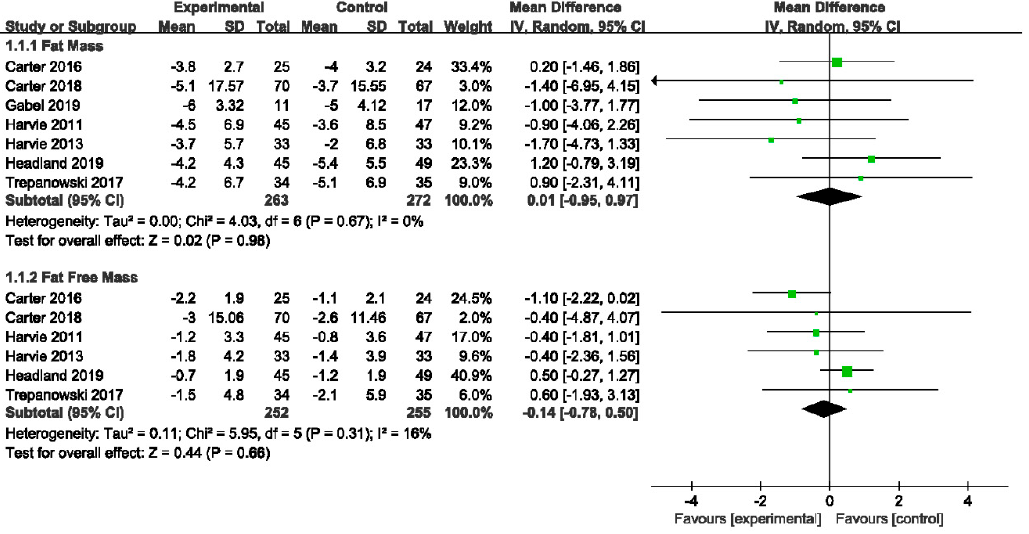
Figure 6. Forest plot for body composition in trials that compared IER with CER. Abbreviations: CI, confidence interval; FM, fat mass; FFM, fat-free mass; IER, intermittent energy restriction; CER, continuous energy restriction. The unit of mean difference in FM and FFM is kg.